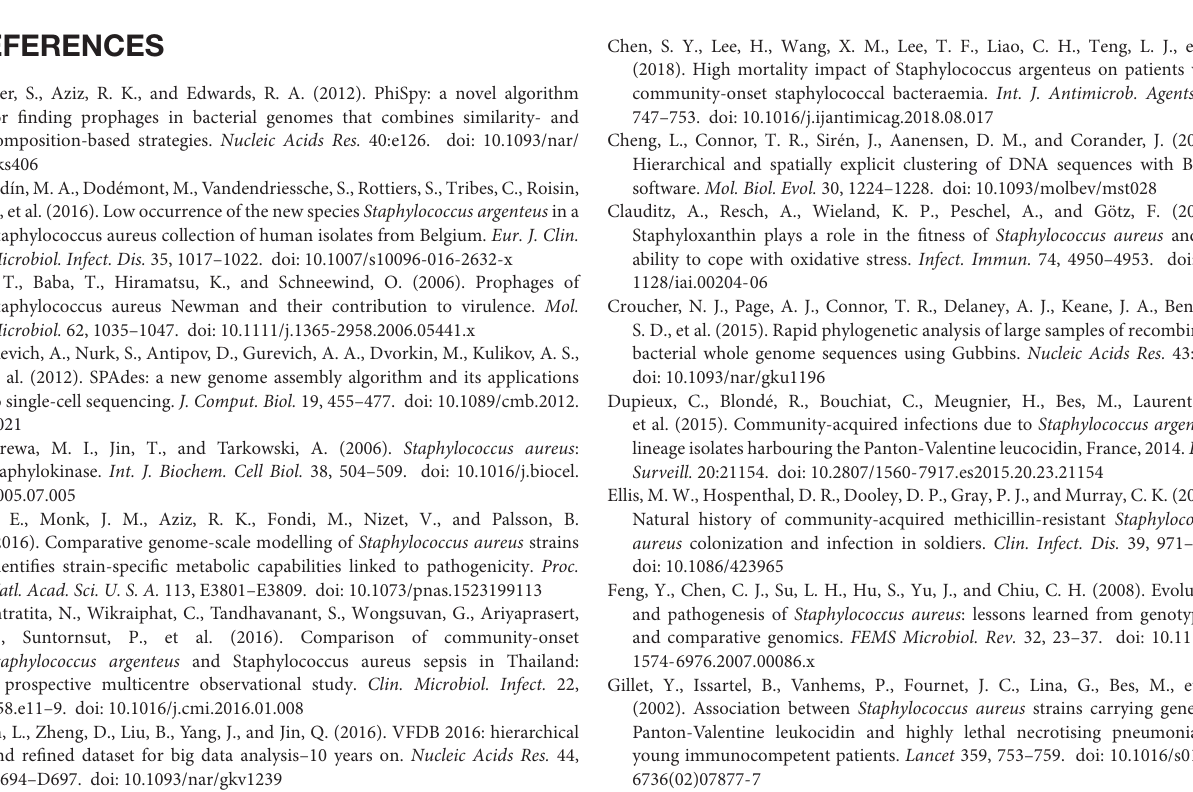
ANI values are presented in a heatmap generated according to the matrix of the percentage identity. Supplementary Figure 3 | Maximum-likelihood tree of S. argenteus constructed from core genome single-nucleotide polymorphisms. The clade colours indicate the location of each strain. The bar colour indicates the BAPS cluster to which each strain is attributed. Supplementary Figure 4 | Maximum-likelihood (ML) tree of S. argenteus constructed from the full alignment of core genes. Supplementary Figure 5 | Pangenome features of 153 analysed S. argenteus strains. The dotted line indicates the number of novel genes discovered with the sequential addition of new genomes. The solid line indicates the values of the core genes as genomes are added to the pangenome. Supplementary Figure 6 | The number of predicted prophages in 153 S. argenteus strains. The clade colours indicate the source of each strain. The bar colour indicates the BAPS cluster to which each strain is attributed. Supplementary Figure 7 | KEGG pathway annotation of East Asia-specific genes in S. argenteus . (A) Beta-Lactam resistance pathway. (B) Vancomycin resistance